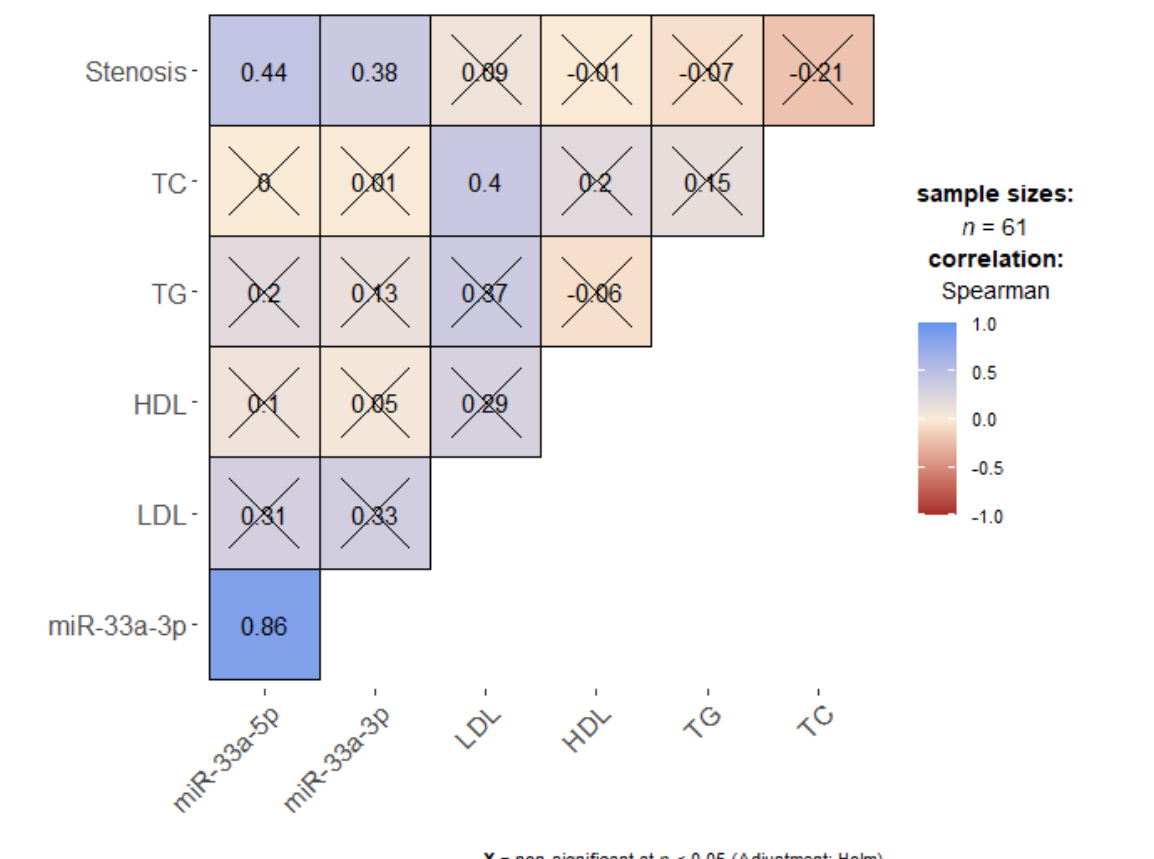
Figure 2. Correlation plot (non-parametric, the number in each box is the Spearman coefficient). Crossed-out are unsignificant (at p < 0.05) correlations. LDL—low-density lipoprotein, HDL—high-density lipoprotein, TC—total cholesterol, TG—triglycerides. The color of the box corresponds to the strength of the correlation (refer to the color legend). Table 4. Univariable linear regression analysis (miR-33a-5p/3p levels—independent